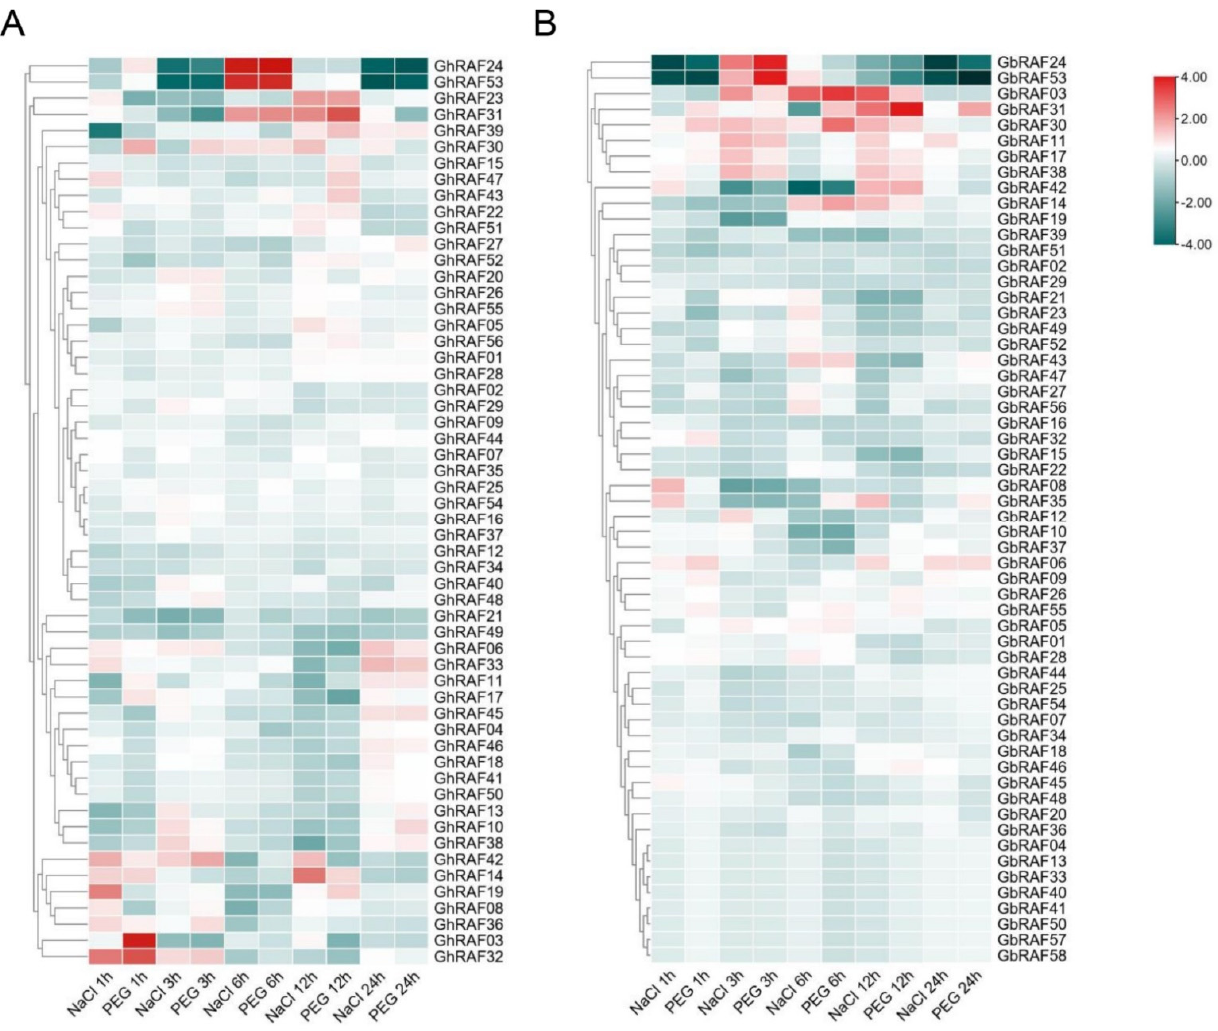
Figure 4. Expression of GhRAF and GbRAF member genes under salt and PEG stress at various intervals of time and acquisition of candidate genes related to salt tolerance ( A ) Transcriptome expression data of G. hirsutum ( B ) Transcriptome expression data of G. barbadense.